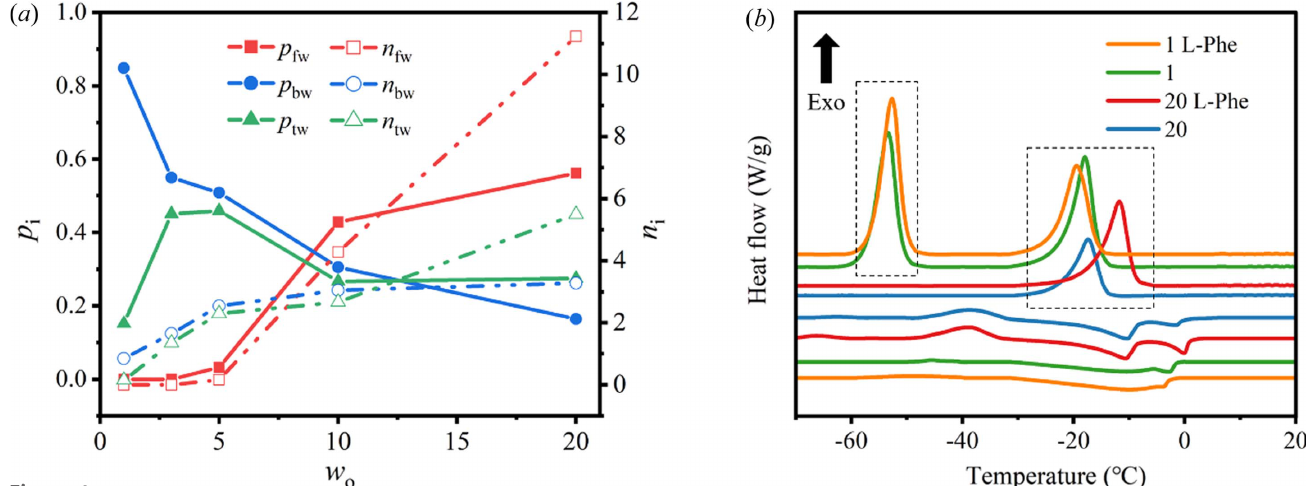
Figure 4 ( a ) Proportion ( p i ) and number ( n i ) of free water (i = fw), bound water (i = bw) and trapped water (i = tw) molecules in the ME vary with w o ; n i refers to the number of water molecules per molecule of surfactant. ( b ) DSC thermograms of the ME with and without l